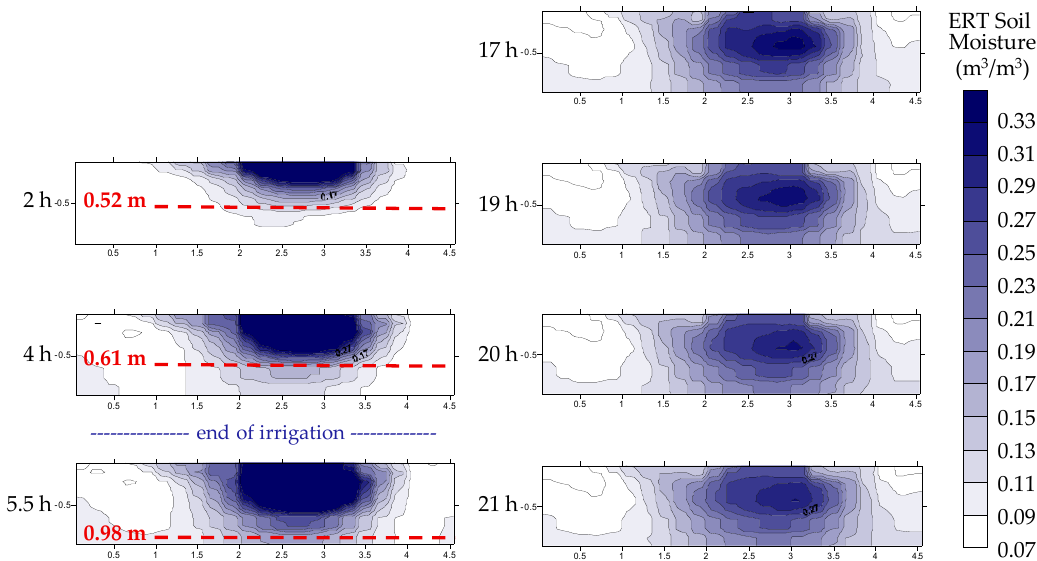
Figure 11. Grugliasco site, August 2009. Moisture content at different times after irrigation, estimated from ERT imaging and laboratory calibrated Archie’s law results. A comparison is made against the depth of the infiltration front estimated by GPR measurements (red dotted lines) [32].